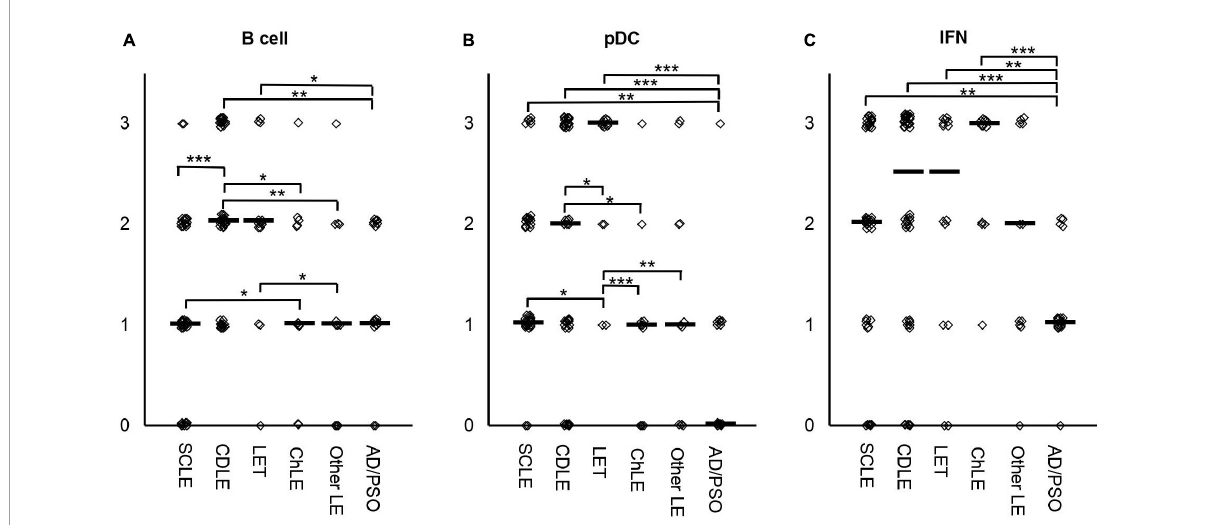
FIGURE1 Semi-quantified score for infiltration of B cells (A) , pDCs (B) or MXA as marker for interferon (IFN) (C) in skin samples of n = 119 lupus erythematosus (LE) and n = 17 inflammatory controls (psoriasis, atopic dermatitis). Immunohistochemical staining was performed to semi-quantify B cells via CD20, pDCs via CD123, and IFN expression via MXA staining. CD20 and CD123 expression was scored according to a semi-quantitative system and ranged from 0: no expression; 1: single cell infiltration; 2: intermediate diffuse or clustered infiltration and 3: strong diffuse or clustered infiltration (A,B) . MXA expression was semi-quantitatively scored from 0: no expression; 1: scant; 2: plenty to 3: abundant expression (C) . The median is highlighted as small bars. Significant differences between groups assessed via Kruskal-Wallis analyses are shown with bars. Significance levels are highlighted as follows: * p < 0.05, ** p < 0.01, *** p < 0.001.